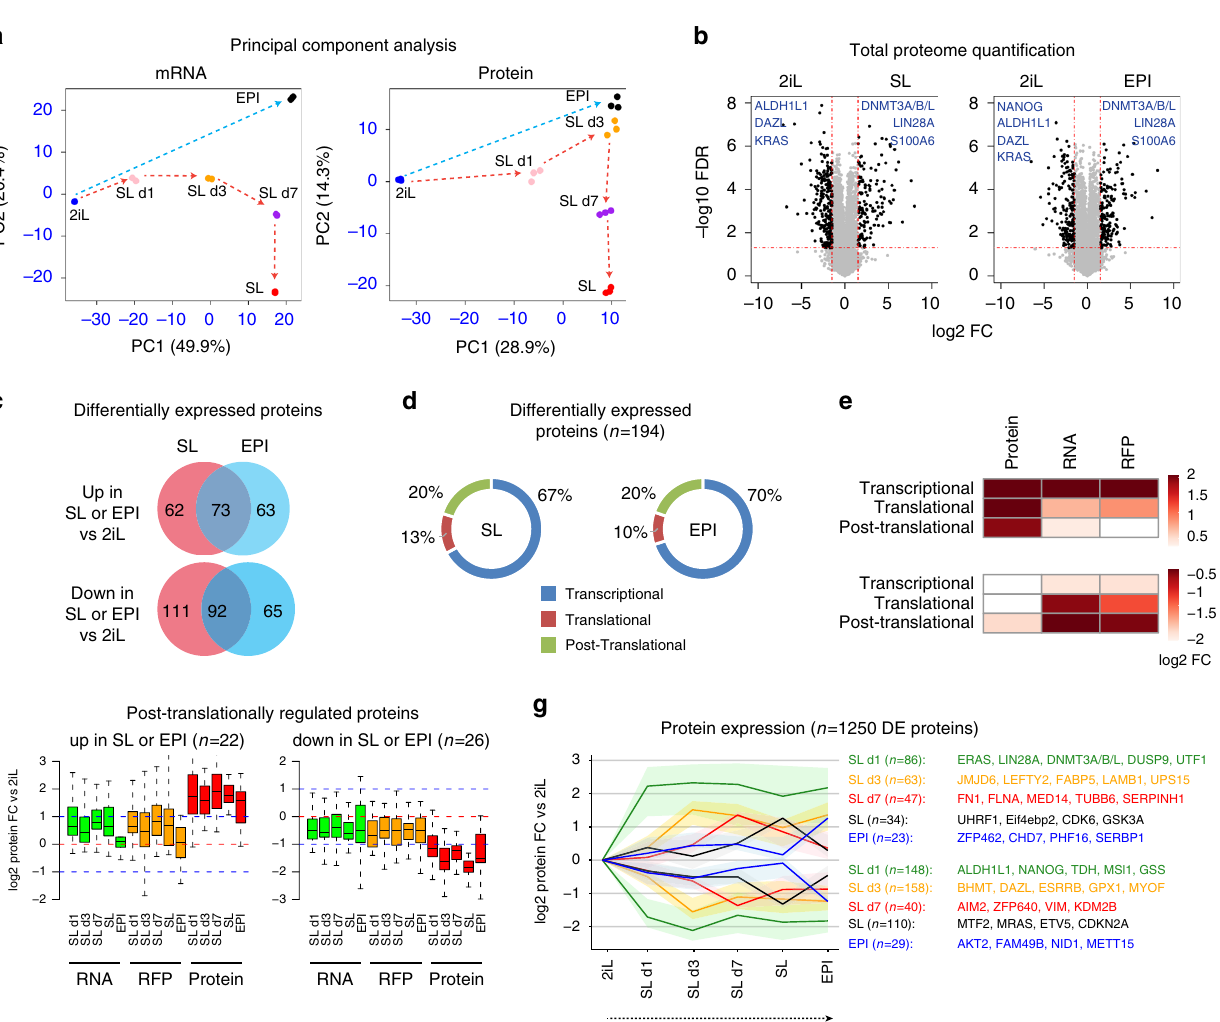
Fig. 3 Widespread proteome alteration is largely associated with transcriptional rewiring. a Principal component analysis of the RNA-seq and proteome data from ESCs collected at different time points of the 2iL to SL and EPI transition. n = 2 biological replicates per time point for RNA-seq and n = 3 biological replicates per time point for total proteome, each dot represents one sample. b Volcano plots showing the label-free total protein quanti fi cation in 2iL, SL, and EPI conditions. Values represent the mean of three biological replicates. Representative examples are shown. Differentially expressed proteins (FDR < 0.05 and FC ≥ 3) are highlighted in black. Differential expression was calculated using the two-sided t -test. c Venn diagram showing the overlap of differentially expressed proteins in SL and EPI when compared to 2iL ESCs. N numbers represent proteins and are stated in the fi gure. d Graphs showing the percentage of differentially expressed proteins with or without change in RNA/RFP when SL or EPI are compared to 2iL state. Transcriptional: protein change >3-fold and RNA change >2-fold; translational: RFP change >2-fold and RNA change <2-fold; post-translational: RNA and RFP change <2- fold. e Heat-map showing the change in RFPs, RNA, and protein in different categories de fi ned in panel c . n = 194 differentially expressed proteins. Values represent mean of log2 fold change. f Box plots showing the changes in RNA, RFP, and protein levels for the post-translationally regulated genes identi fi ed in panel c and during the 2iL-to-SL and EPI transition. n represents the number of proteins as indicated in the fi gure. Box = 25 – 75th percentile; bar = median; whiskers = 5 – 95th percentile. g Expression pattern of differentially expressed proteins in at least one time point of 2iL to Sl and EPI transition. Lines in the plots represent average fold-change of protein expression and shaded bands represent upper 75% and lower 25%